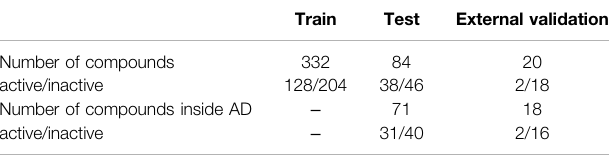
TABLE 2 | Number of compounds for each dataset.